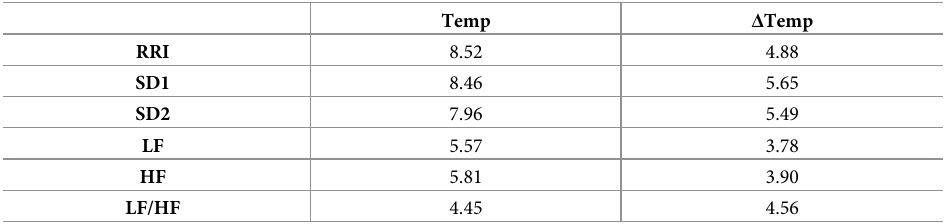
Table 2. Euclidean distance of core body temperature with indexes from ECG